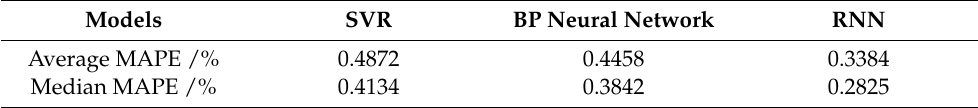
Table 3. Comparison of prediction errors of different